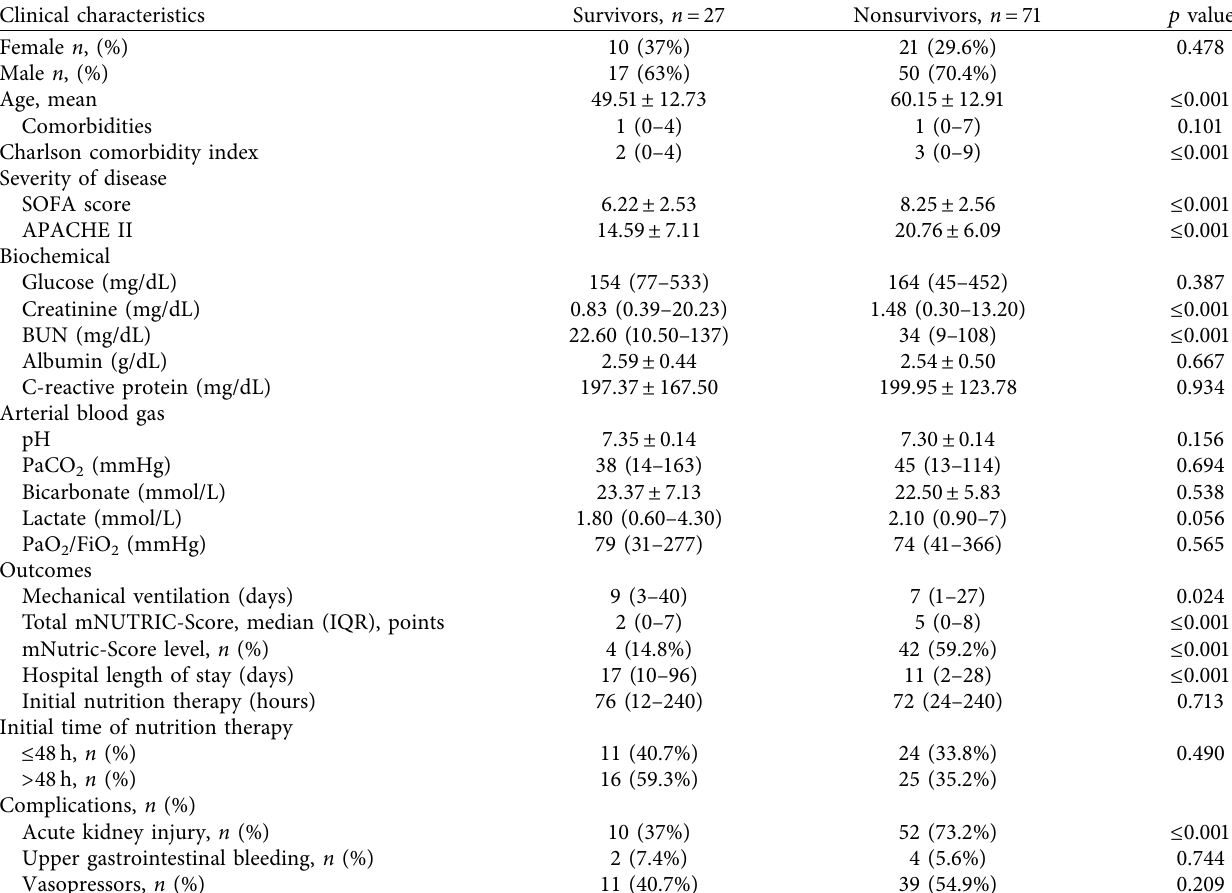
Table 3: Comparison of each item among 28-day survivors and nonsurvivors.